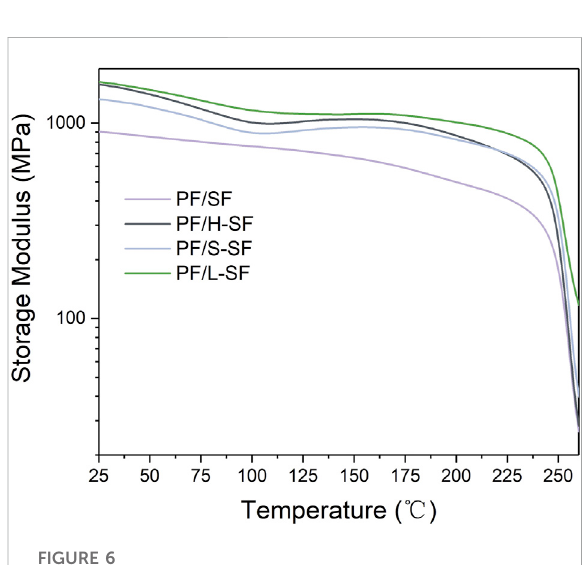
FIGURE 6 Storage modulus of PF/SF, PF/H-SF, PF/S-SF, and PF/L-SF at different temperatures with the fi ber content at